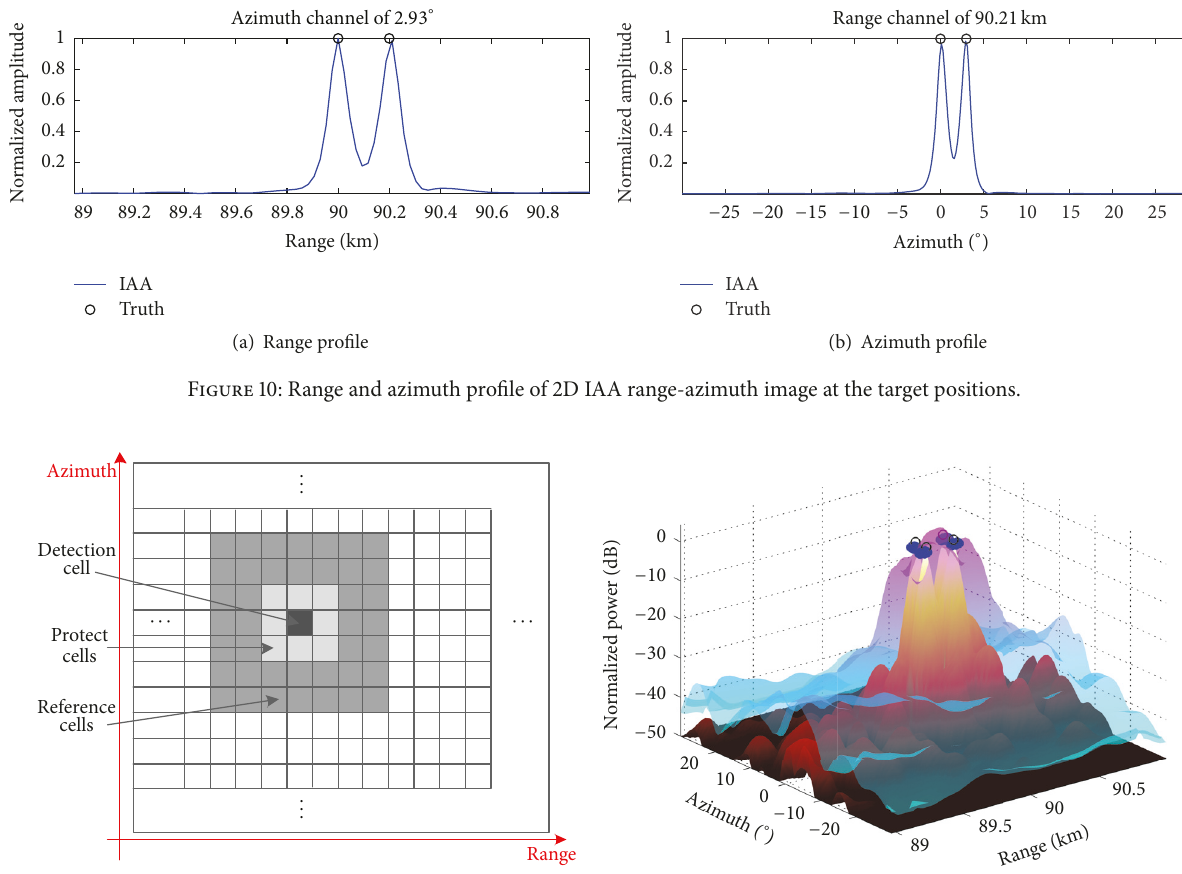
(b) Detection results on 2D IAA range-azimuth spectrum Figure 11: The detection process